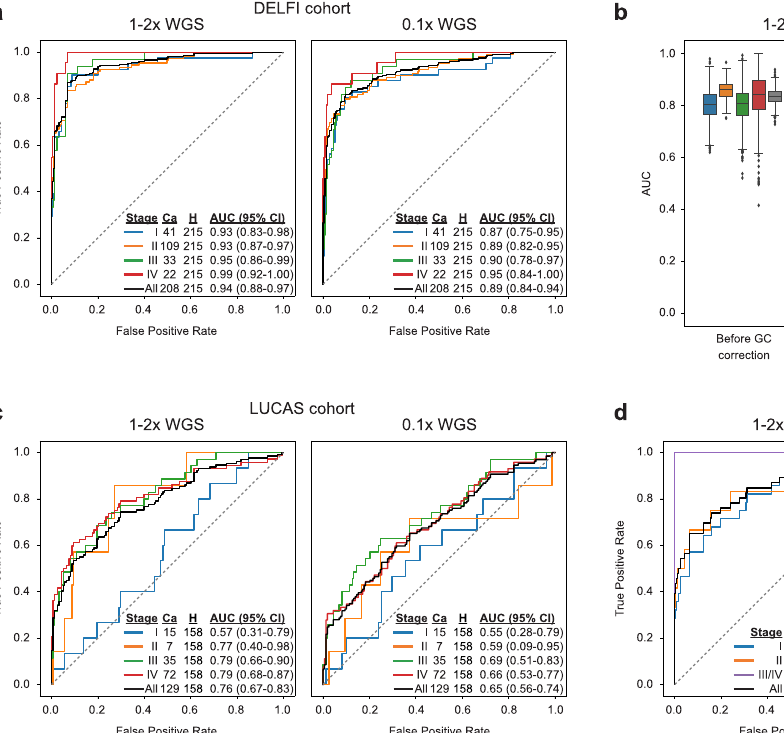
cancers and 215 healthy controls. b Comparison of the performance in the DELFI cohort before and after GC correction using Grif fi n. Samples are the same as in a . Boxplots indicate median, interquartile range (IQR), whiskers for 1.5× IQR, and outliers. c Performance of the LUCAS cohort 45 consisting of plasma from 129 lung cancer patients and 158 healthy patients. d Performance of the LUCAS validation cohort 45 consistingofplasmafor46lungcancersand385healthycontrols.Foreach dataset,performanceisshownforboththeoriginallowpass(1 – 2×)WGSandultra- lowpass(0.1×)WGSgeneratedbyin-silicodownsampling.Sourcedataareprovided as a Source Data fi